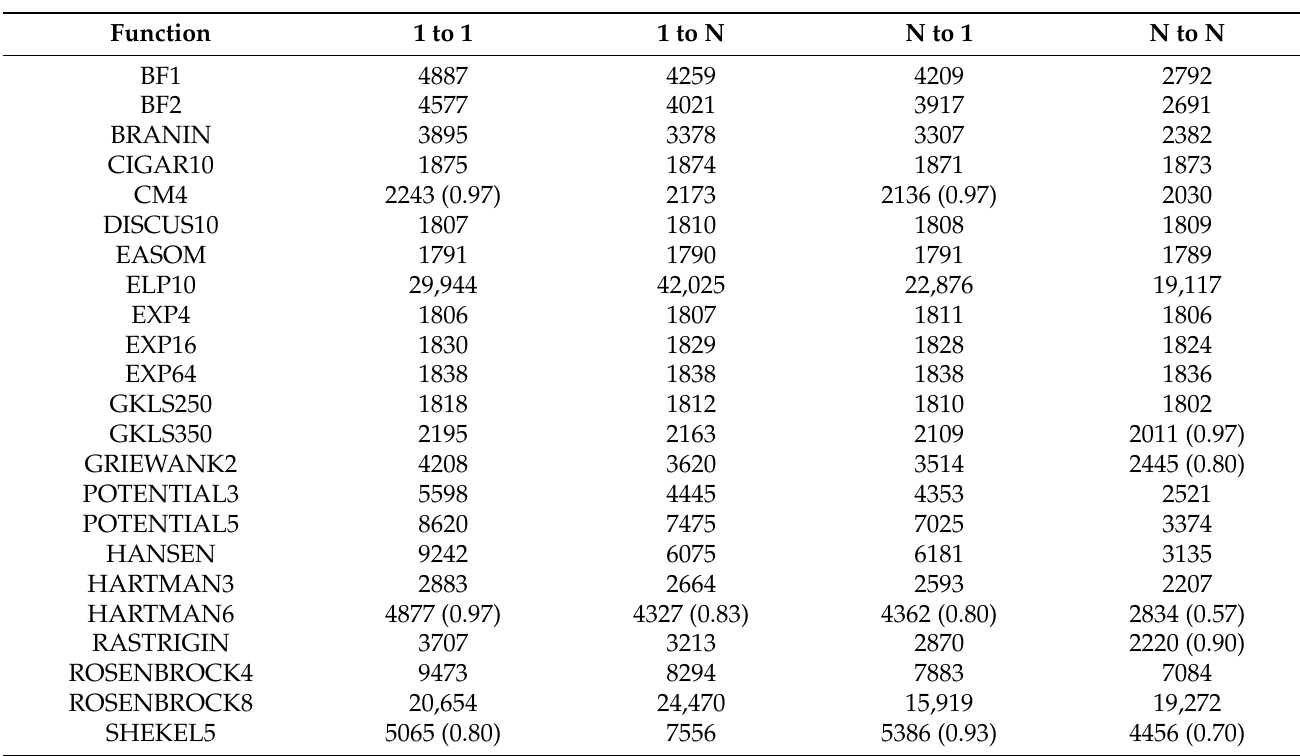
Table 3. Experiments for the proposed method using different options for the propagation method. The number of processing threads was set to 10. Numbers in cells represent average function calls for every test